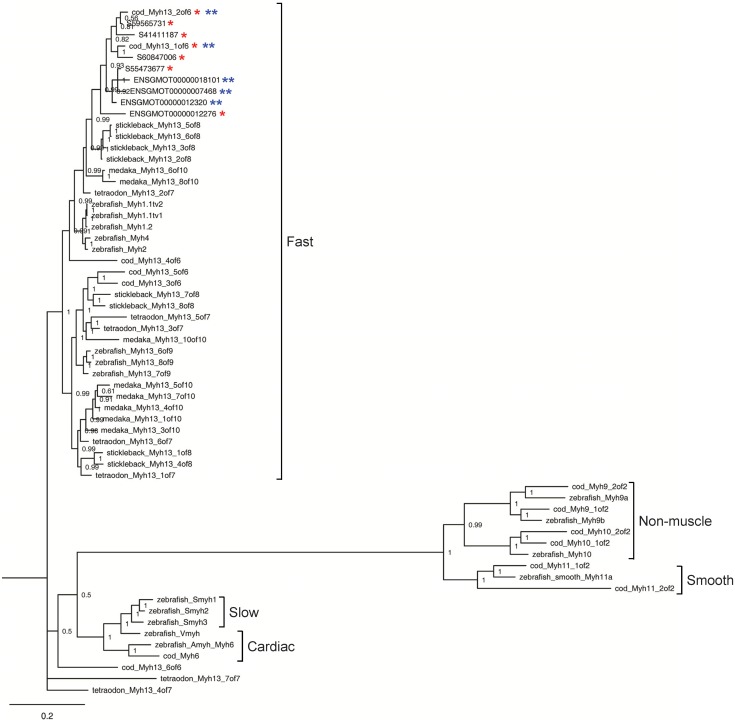
Phylogenetic inference of myosin heavy chain (myh) genes in vertebrates.Red and blue asterisks indicated the myh clones annotated to UniGene and Ensembl reference data sets, respectively. Numbers at the nodes indicate posterior probability values obtained from the Bayesian analysis. Ensembl transcript IDs and NCBI accession nos. of teleost myh13 genes can be found in S6 and S7 Tables, respectively.